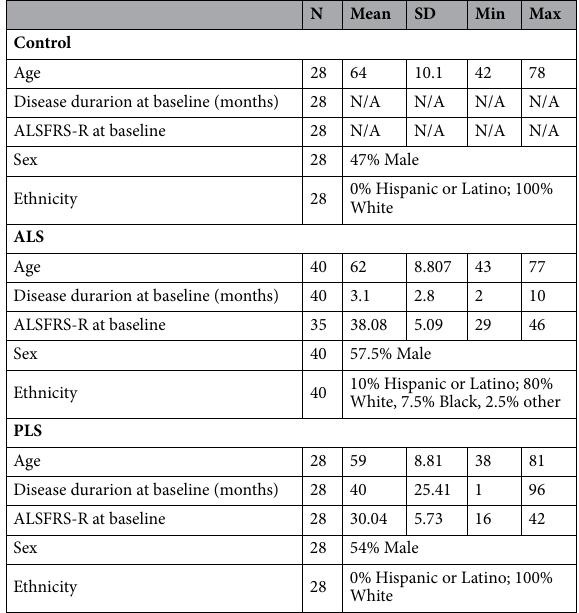
Table 1. Characteristics of ALS and PLS patients and